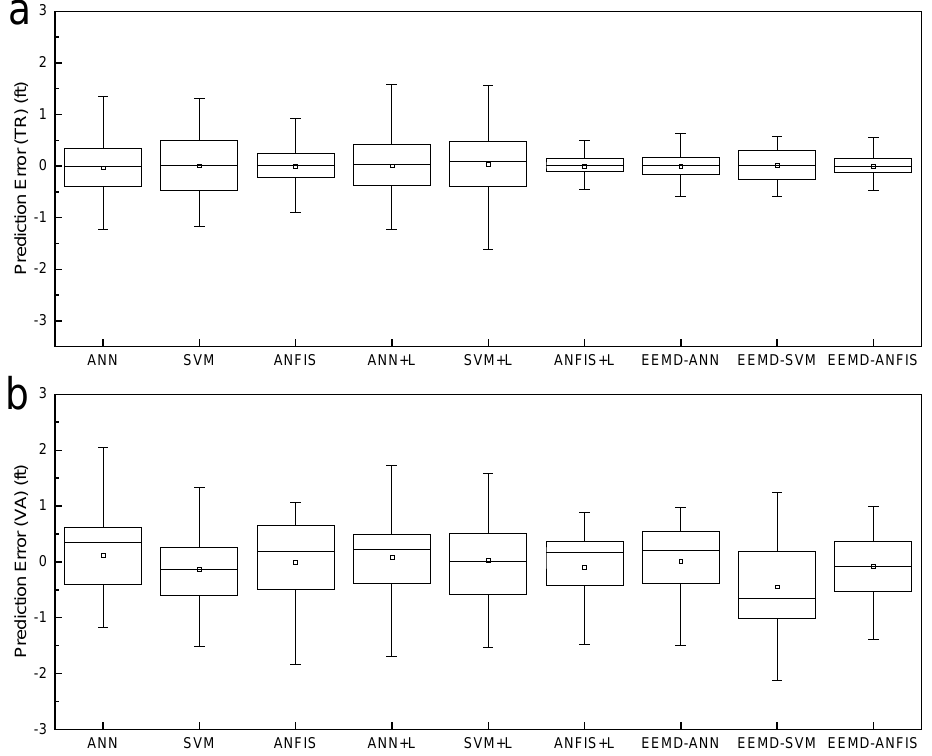
Figure 18. Box plots of prediction error at site STL185 ( a ) Tr—Training; ( b ) Va—Validation.